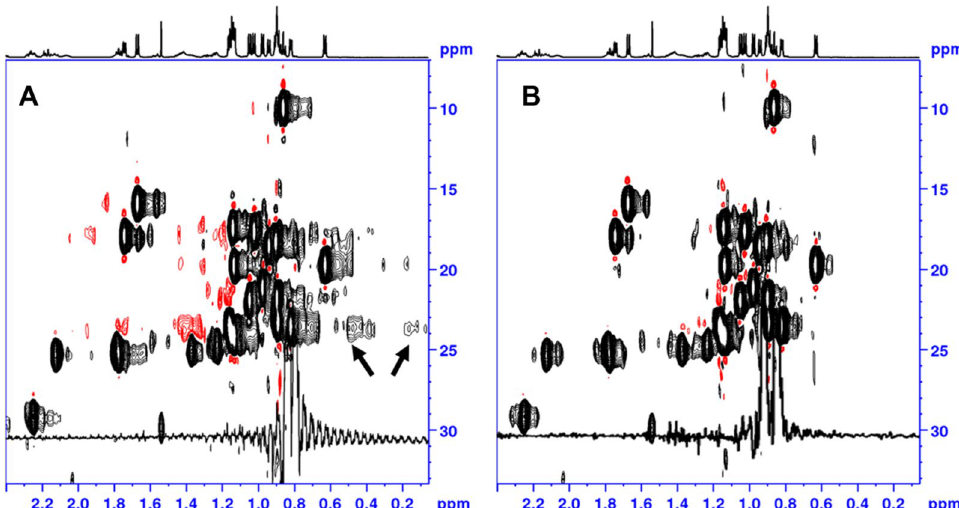
Figure 2. The spectra were collected using a 25 mM solution of Cyclosporine in deuterated benzene (C 6 D 6 ) utilizing the pulse sequence depicted in Fig. 1. The BBHD HSQC spectrum in Fig. 1A was recorded using the hsqcetgpsp.2_bbhd pulse program as given in the Bruker library as reference for comparison. The reference experiment is using a BIRD d pulse cascade and no variation of delay length to produce the spectrum. Sideband artefacts around the methyl region (δ 1 H/ 13 C 0.8/23 ppm) are detected. The BIRD r,X spectrum without RRD shows identical artefacts and is hence not shown. In ( B ) the applied RRD real time HD (BIRD r,X ) delivers a better suppression of those sideband artefacts. During every scan, the length of data chunks as well as RF blocks is slightly changed between distinct previously set times. Yet the same delay settings are used from increment to increment. A significant reduction of signal sidebands is achieved leading to a better noise characteristic (see Fig. 3). The RRD real time BIRD pulse sequence (Fig. 1) is utilizing a set of limited randomly generated delays. The experiments in this paper were recorded using a Bruker-Avance III spectrometer (Bruker BioSpin, Rheinstetten, Germany) at 600.13 MHz proton frequency. The system is equipped with a 5 mm triple resonance TCI-Cryoprobe. A z-axis pulsed field gradient unit (PFG) was used either for coherence selection or as crusher gradients to destroy unwanted magnetization. The spectra shown in this paper were processed with the processing software Topspin 3.6.2 46 . The temperature for all samples was kept at 298 K. The experiment utilized a 13 C sweep width of 22.64 kHz (t 2 (max) of 5.65 ms with an FID resolution of 176.8 Hz/point, number of complex points: 128). The spectral width in direct 1 H dimension was set to 12,019.2 Hz giving an acquisition time of 127.7 ms with a physical dwell time of 83.2 us (number of complex points: 1536). All spectra were acquired using non-uniform sampling to speed up data acquisition. The built-in Topspin nussampler was used to create the point spread 47 . A NUS amount of 40% was chosen to sample the data points in the indirect dimension leading to 51 of 128 complex points. NUS reconstruction was done using compressed sensing (CS) 47–52 . Total measurement time of the reference and RRD real time homodecoupled HSQC experiment was 33 min. The 2D data set was apodised by multiplying with a shifted sine squared function (shift of 90°) and then zero-filled to yield a final matrix of 4096 (F 2 ) × 1024 (F 1 ) data points. In case a post processing phase correction in F 2 is required, a Hilbert transform can be executed to retrieve the imaginary data points in F 2 , not calculated by NUS reconstruction (TopSpin command xht2) 46 . All spectra in Figs. 2, 4 and 5 were plotted by Topspin 3.6.2 and exported in TIFF format utilizing Microsoft PowerPoint for Microsoft 365 MSO (16.0.13801.20928) 64-bit graphic export